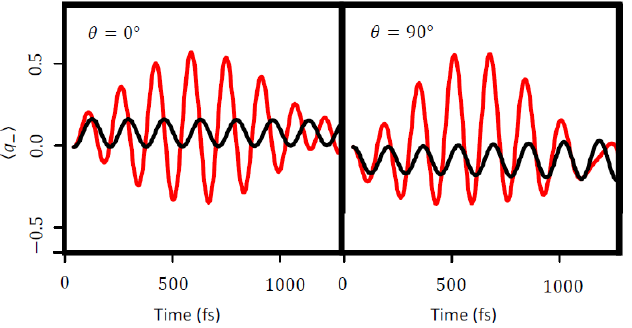
Fig. 2. Average vibrational wavepacket coordinates for two different excitation polarizations in the molecular frame. Left) Polarization at 0 drives initial vibrational motion to positive coordinates. Right) Polarization at 90 drives initial vibrational motion to negative coordinates. For both panels, the motion that results from the adiabatic approximation is shown in black and nonadiabatic wavepacket motion is shown in red. The larger amplitude vibration in red illustrates the electronic amplification of coupled vibrational motion during energy